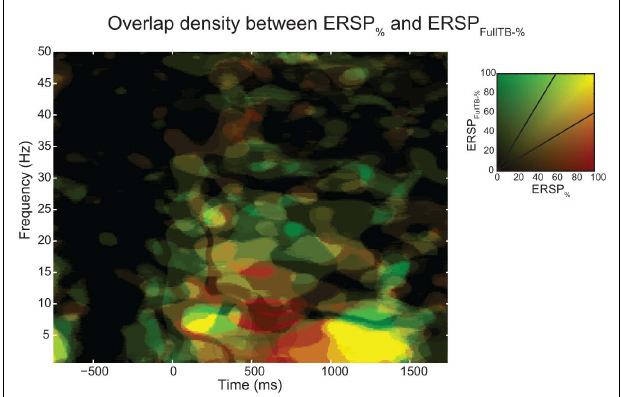
FIGURE 9 | Density of ERSP % and ERSP FullTB − % significant pixels across subjects and their overlap. ERSPs were computed for electrode Iz of 14 subjects and significant pixels were computed using the baseline permutation method (see Materials and Methods). ERSP “density” represents the percentage of significant subject at each time–frequency point from 0 to 100% (all 14 subjects). ERSP % density of significant pixels is represented in green, ERSP FullTB − % density in red, and the overlap between ERSP % and ERSP FullTB − % densities is shown in yellow. Density is coded by color saturation level, higher densities are shown with higher saturation